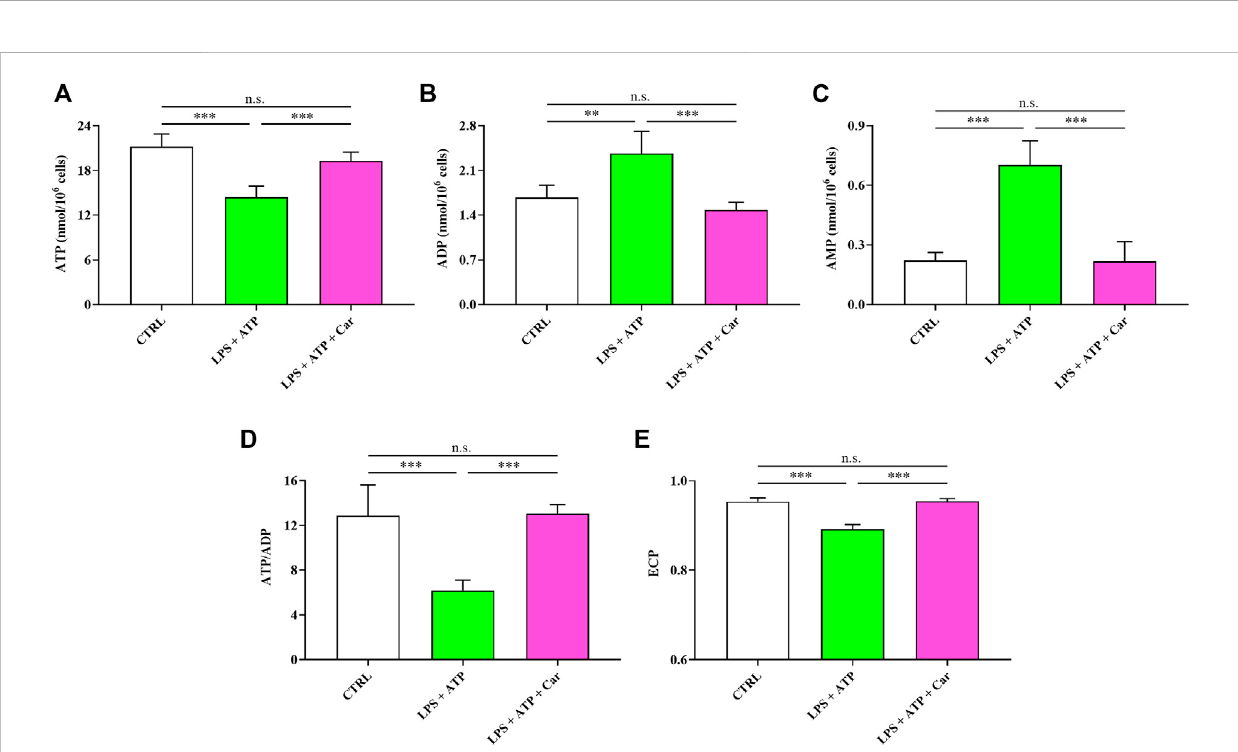
FIGURE 3 Values of (A) ATP, (B) ADP, (C) AMP, (D) ATP/ADP ratio, and (E) Energy Charge Potential (ECP = ATP +1/2ADP/ATP + ADP + AMP) determined in resting HMC3 cells and HMC3 cells exposed to LPS (100 ng/mL, 24 h) + ATP (5 mM, 30 min), in the absence or presence of carnosine (Car) (10 mM, 1 h pre-treatment). Data represent mean of four different samples. Standard deviations are represented by vertical bars. **Signi fi cantly different, p < 0.01; ***Signi fi cantly different, p <